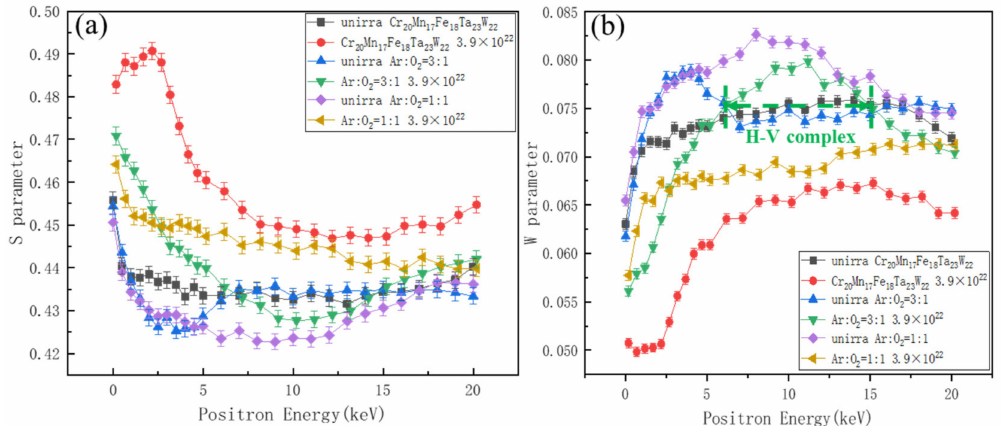
Figure 12. ( a , b ) S and W parameters as a function of the positron energy for Cr 20 Mn 17 Fe 18 Ta 23 W 22 ; HT1 and HT3 specimens before and after H + irradiation, respectively.